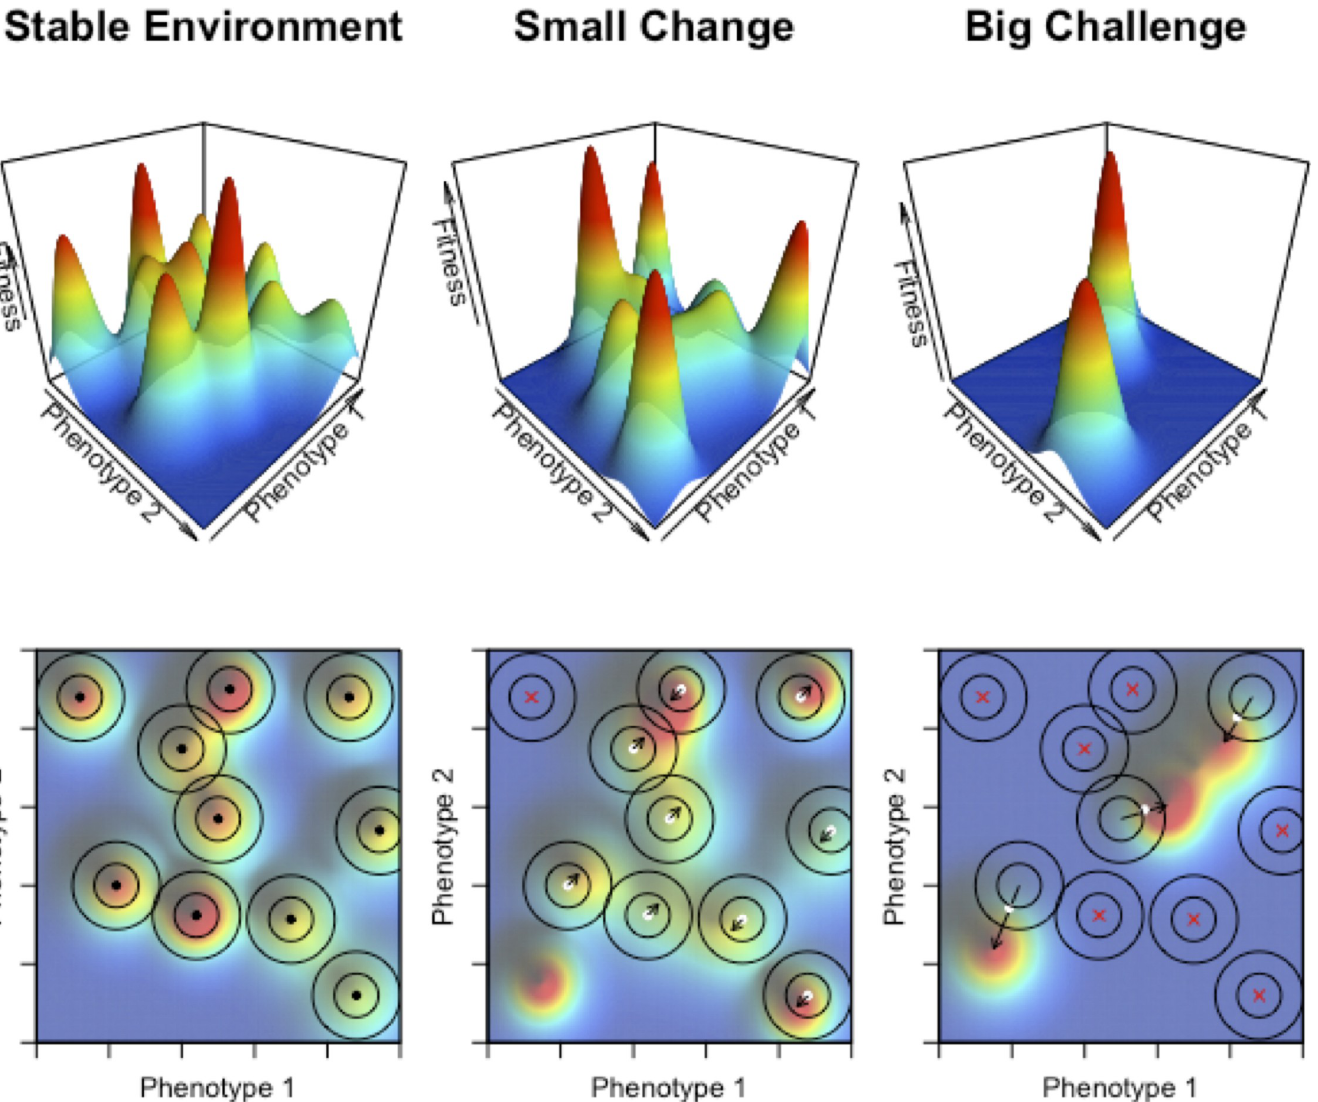
Fig 8. The role of polyploidy in exploring the fitness landscape under different environmental scenarios. Top panels, 3D surface representation of the phenotype space accessible for every combination of two hypothetical phenotypic traits, which ultimately correspond to an organism’s specific genotypic configuration. Each coordinate in the XY plane conformed by phenotype 1 and phenotype 2 has a relative fitness value associated on the Z axis. The resulting fitness landscape is formed by a range of hills, each corresponding to the total phenotype space accessible to a specific organism or group of organisms, i.e, their ecological niche, with a local maximum or adaptive peak located at the top. Hills are surrounded by valleys or depressions, colored in dark blue, corresponding to regions of the phenotype space inaccessible to any organism. Bottom panels show the 2D colored image plots corresponding to the fitness landscapes above. Black dots, white dots and red crosses represent organisms occupying the fitness landscape. Concentric circles around organisms represent the areas of the phenotype space accessible by non-polyploid organisms (inner circle) or their polyploid relatives (outer circle). Arrows indicate the trajectories followed by every organism to reach their adaptive peak. Black dots represent organisms that have reached their local maxima and are thus located at their adaptive peaks; white dots represent organisms that survived after a change in the environmental conditions and subsequent shifts of their adaptive peaks; red crosses represent organisms that perish because of big shifts or extinction of their niches. From left to right, three different environmental scenarios are shown. In the left two panels, organisms evolving under a stable environment for a certain time are expected to have reached their local adaptive peaks. In the middle two panels, a small change in environmental conditions (e.g., a small drop in the total food available) may result in small shifts of the peaks or their relative fitness contribution, or eventually in the extinction or emergence of specific ecological niches. In most cases, the new location of the peaks fall within the phenotype area (still) accessible to non-polyploid organisms (inner circles). Under this scenario, non-polyploid organisms are expected to quickly reach the new peaks, rapidly outcompeting their polyploid relatives, which are more likely to fall farther away (outer circles) and have well-known detrimental effects. Finally, in the right panels, a cataclysmic or extinction event (e.g., a big drop in the total food available) is represented, resulting in a reduction in the number of available ecological niches, and big shifts in their relative locations. Under these conditions, although most organisms are expected to perish, polyploids organisms, featured by wider accessible phenotype space (as a result of the potential higher impact of mutations in more complex genomes, see text for details), have better chances to fall near the peak of a newly formed adaptive hill and to develop the necessary evolutionary innovations to colonize empty